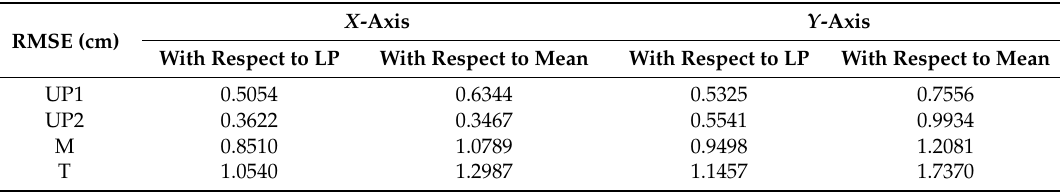
Table 5. Displacement error for each LED position with respect to LP LED and